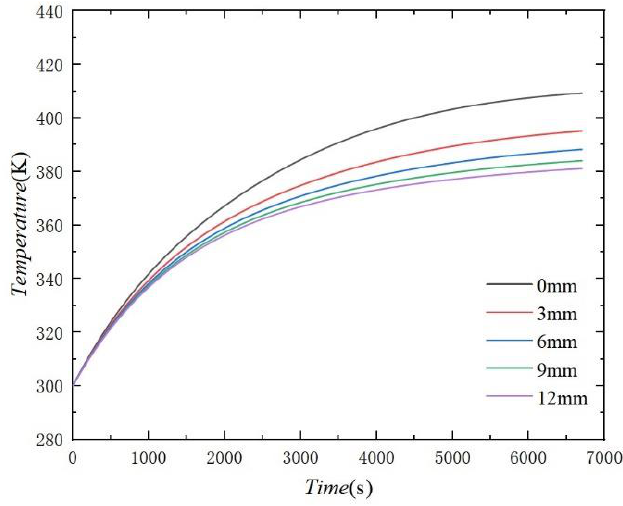
Figure 11. Temperature of accessory 1 when adding a heat insulation layers of different thicknesses to the casing.